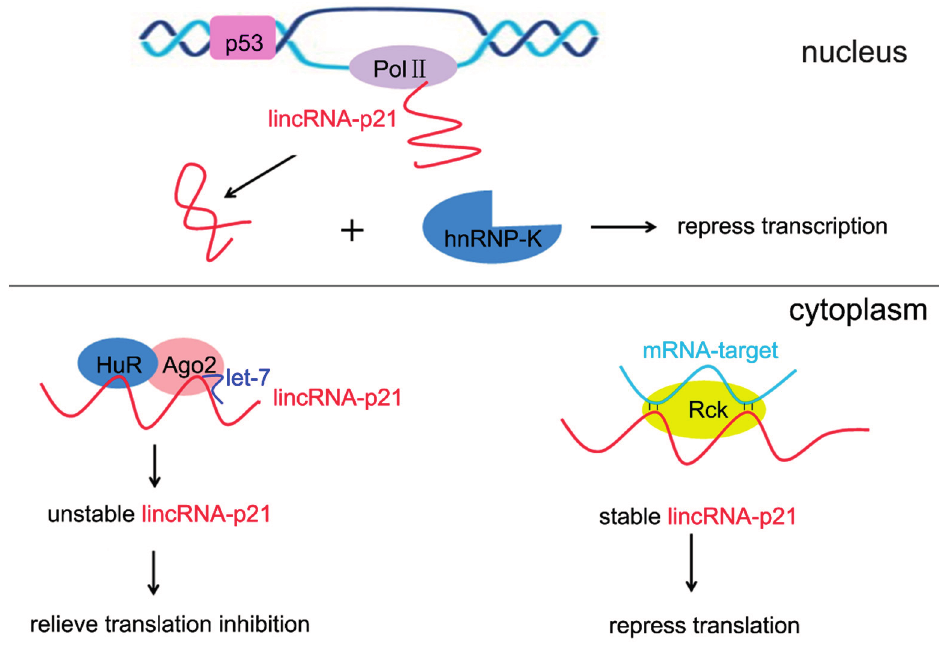
Figure 2. The roles of lincRNA-p21 in gene regulation. In the nucleus, lincRNA-p21 is a RNA Pol II transcript and is capped, spliced and polyadenylated. LincRNA-p21 interacts with hnRNP-K protein through a relatively conserved 5 ʹ terminus and represses the transcription of target genes as part of the canonical p53 transcriptional response. In the cytoplasm, HuR is shown to interact with lincRNA-p21 and destabilize lincRNA-p21 by recruiting a let-7/Ago2 complex. LincRNA-p21 recognizes mRNA targets by basepairing and represses their translation in coordination with the Rck RNA